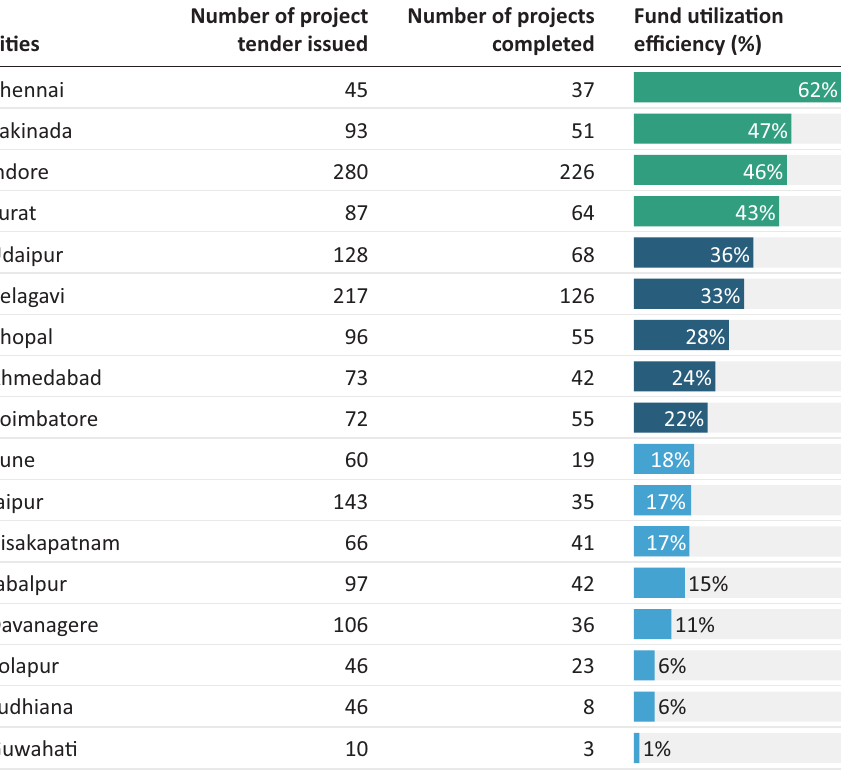
Figure 5. Status of project completion and fund utilization by the top 20 cities selected in the first phase of SCM. Note: Data for three cities in this list (Bhubaneswar, Kochi, and New Delhi) were not